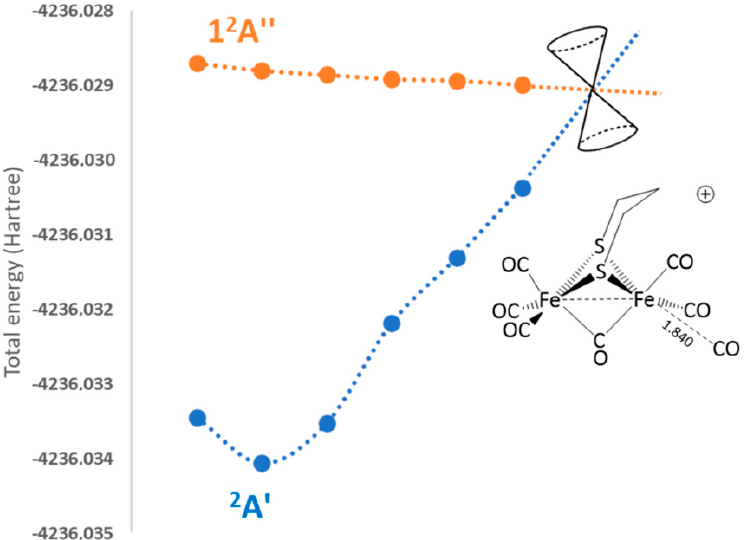
Figure 11. TDDFT-optimization energy profiles for the first excited state of 2 a + –CO (1 2 A” in orange), starting from the 2.200 Å syn trans Fe–CO elongated structure, evidencing the conical intersection with the ground state (in blue) reached after 7 optimization cycles at Fe–CO 1.840 Å. Energies in Hartree.